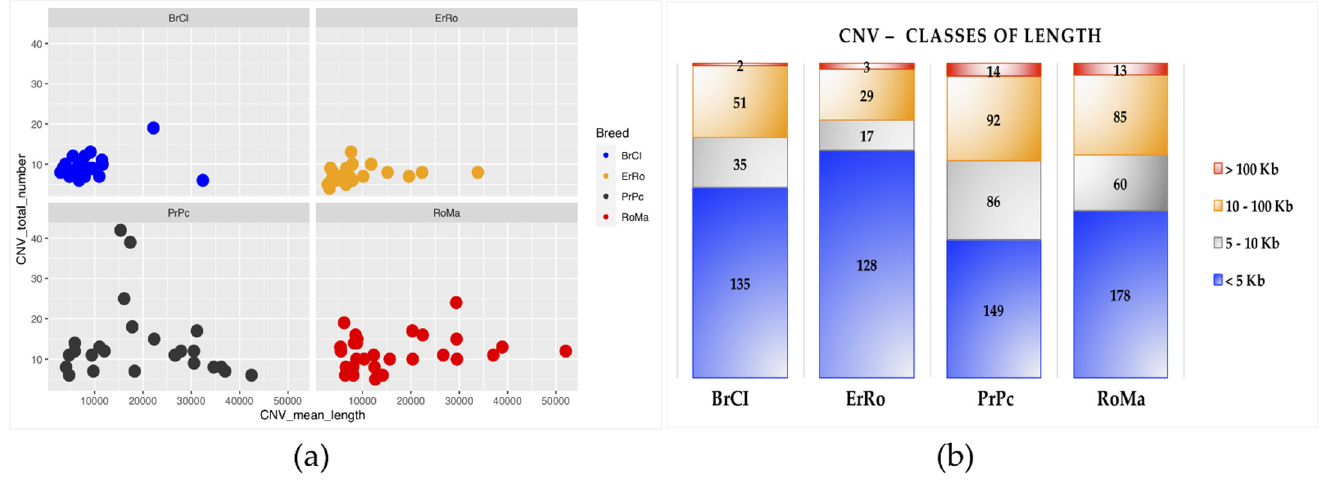
Figure 1. Graphical representation of CNVs statistics: ( a ) relationship between samples CNVs number and mean CNV length (bp) per birds; ( b ) number of CNVs for each class of length per breed.